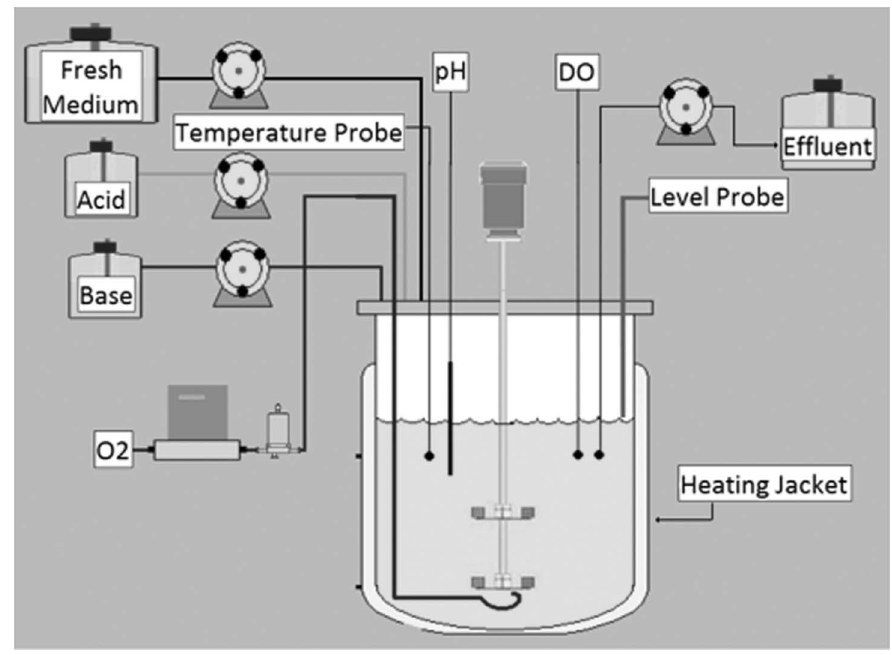
Figure 2. Schematic of bioreactor design and